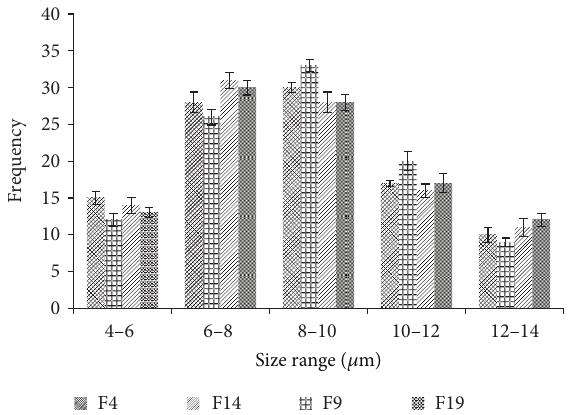
Figure 2: Size distribution plots of all optimized